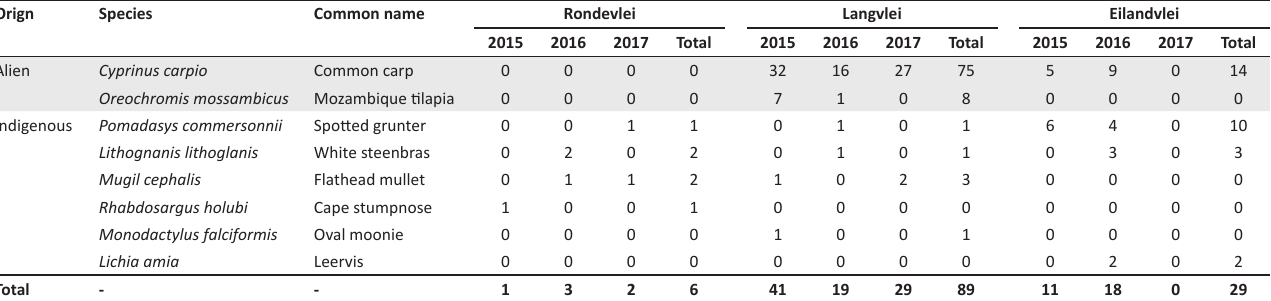
TABLE 4: The number of dead fish located in Rondevlei, Langvlei and Eilandvlei in the three different botulism outbreak periods encompassing January–June 2015, November 2015 – August 2016 and January–May 2017. Orign Species Common name